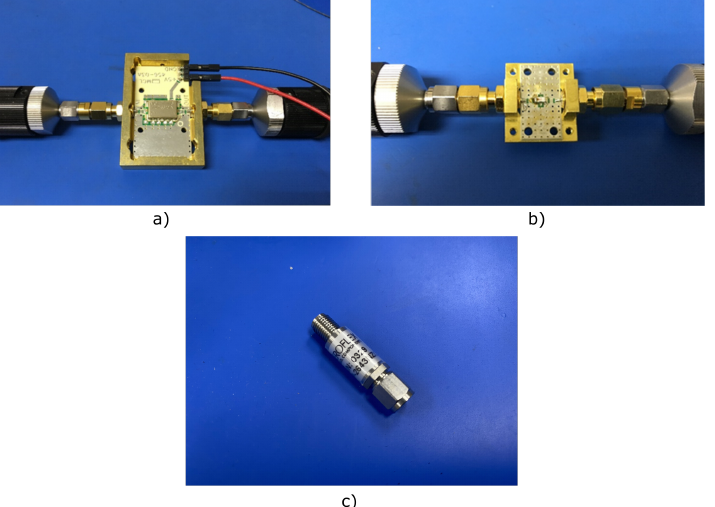
Figure 4. Photographs of the COTS components: ( a ) Low-noise amplifier TAMP-362GLN+ (case style JQ1382) assembled on its evaluation board. ( b ) Band-pass filter BFCN-3600+ (case style FV1206) assembled on its evaluation board. ( c ) Schottky diode coaxial detector